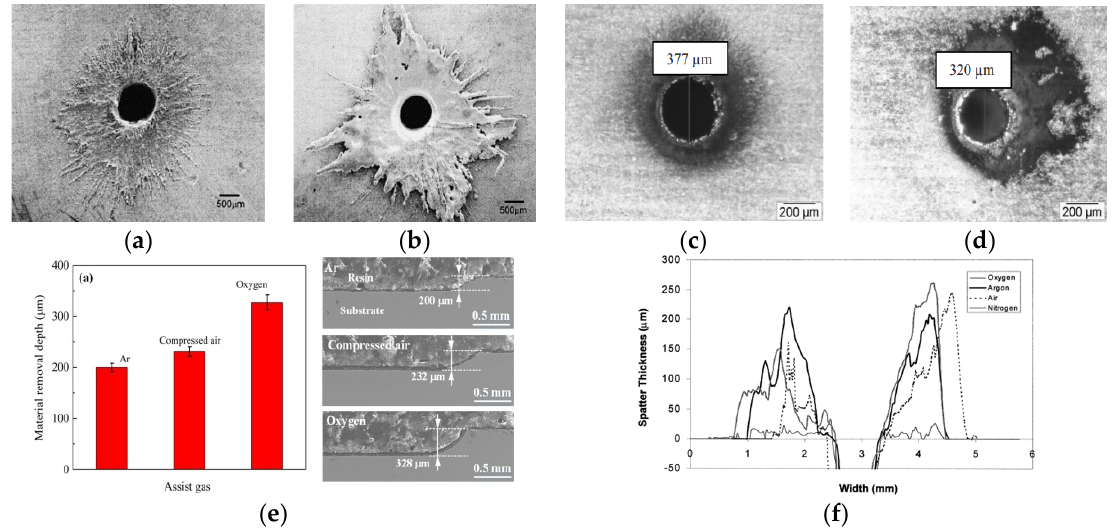
Figure 8. Typical measured spatter thickness geometry: ( a ) oxygen, ( b ) argon; ( c ) compressed air; ( d ) nitrogen, reprinted with permission from [106,107], copyright from Elsevier 2000, 2011; ( e ) material depth and cross-section shapes of laser etched with argon, compressed air, and oxygen, reprinted with permission from [36], copyright from Elsevier 2021; ( f ) spatter height with various gases, reprinted with permission from [106], copyright from Elsevier 2000.